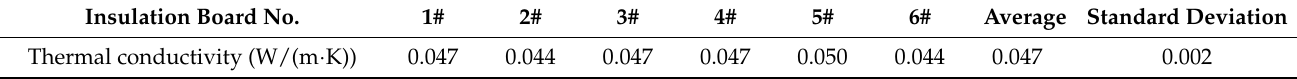
Table 3. Thermal conductivity of the test